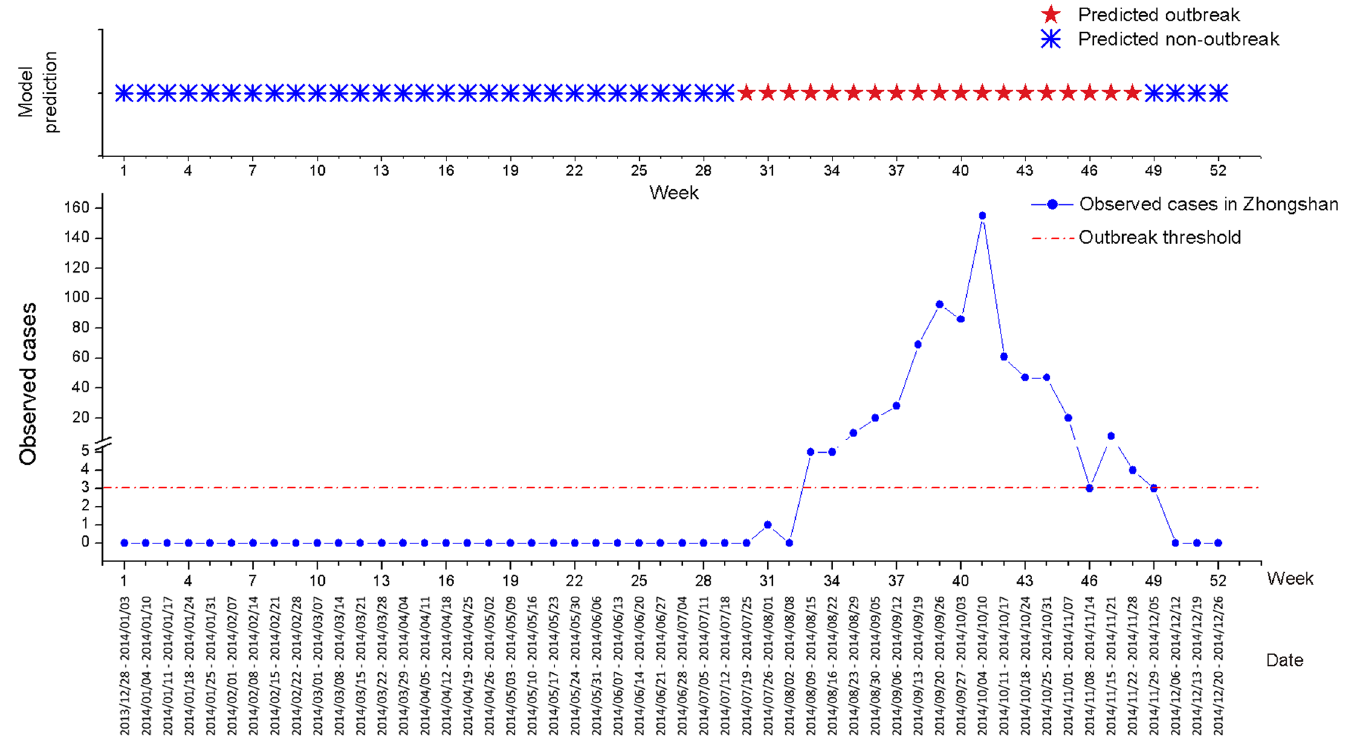
Fig 6. Out-of-sample prediction for dengue epidemics in Zhongshan (2013/12/28 – 2014/12/26).